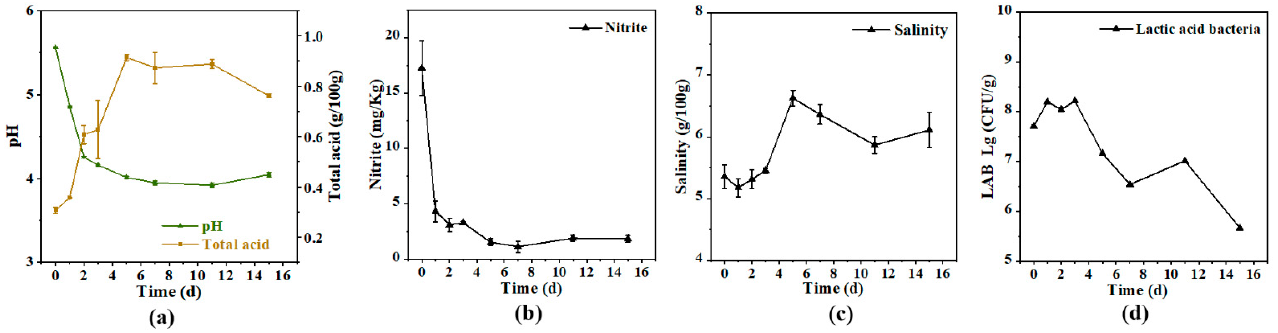
Figure 3. Biochemical of Apo pickle during fermentation. ( a ) pH and total acids; ( b ) nitrite; ( c ) salinity; ( d ) lactic acid bacteria.